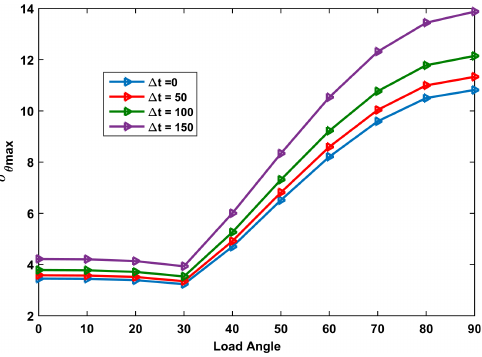
Figure 10: Effect of ∆t and load angle on (a/b = 2, Load angle varia- tion from 0 ∘ to 90 ∘ axis, [ − 45 /45]s)